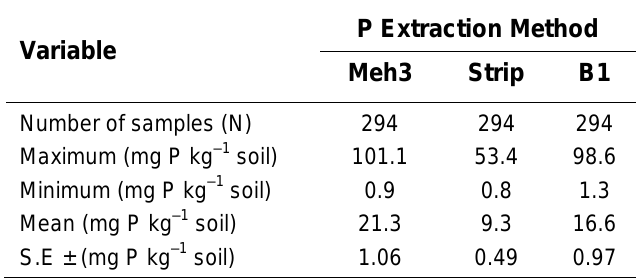
Amounts of P Extracted by the Three Soil Test Methods